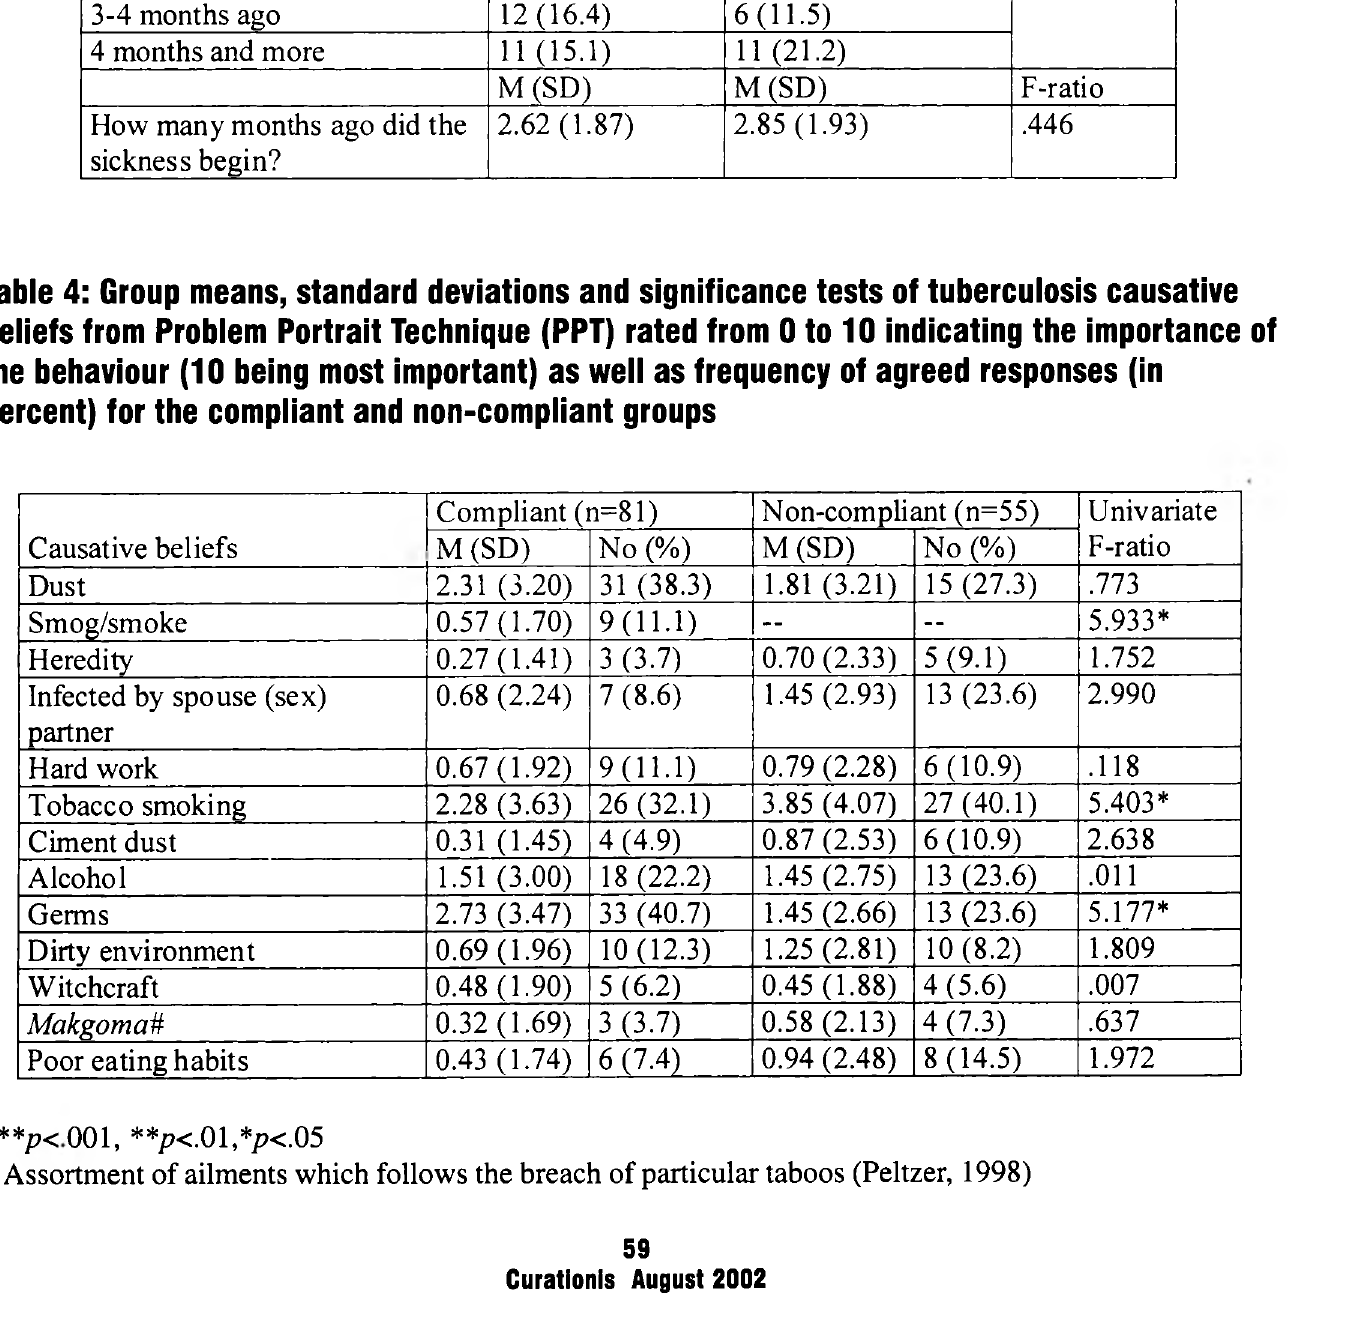
When did the illness start